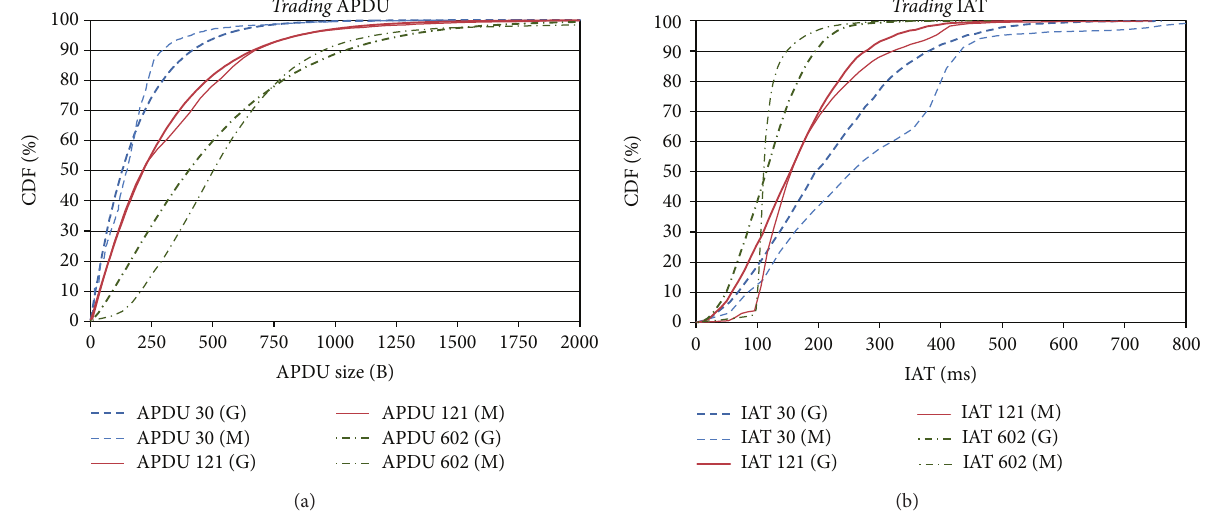
Figure 2: CDFs of (a) APDU and (b) IAT for different numbers of players for measured (M) and simulation generated (G) traces of Trading.